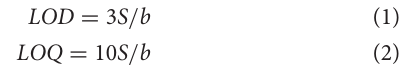
TABLE 1 | Measurement techniques and respective conditions for the determination of the sorption isotherm of Kurile larch. Method